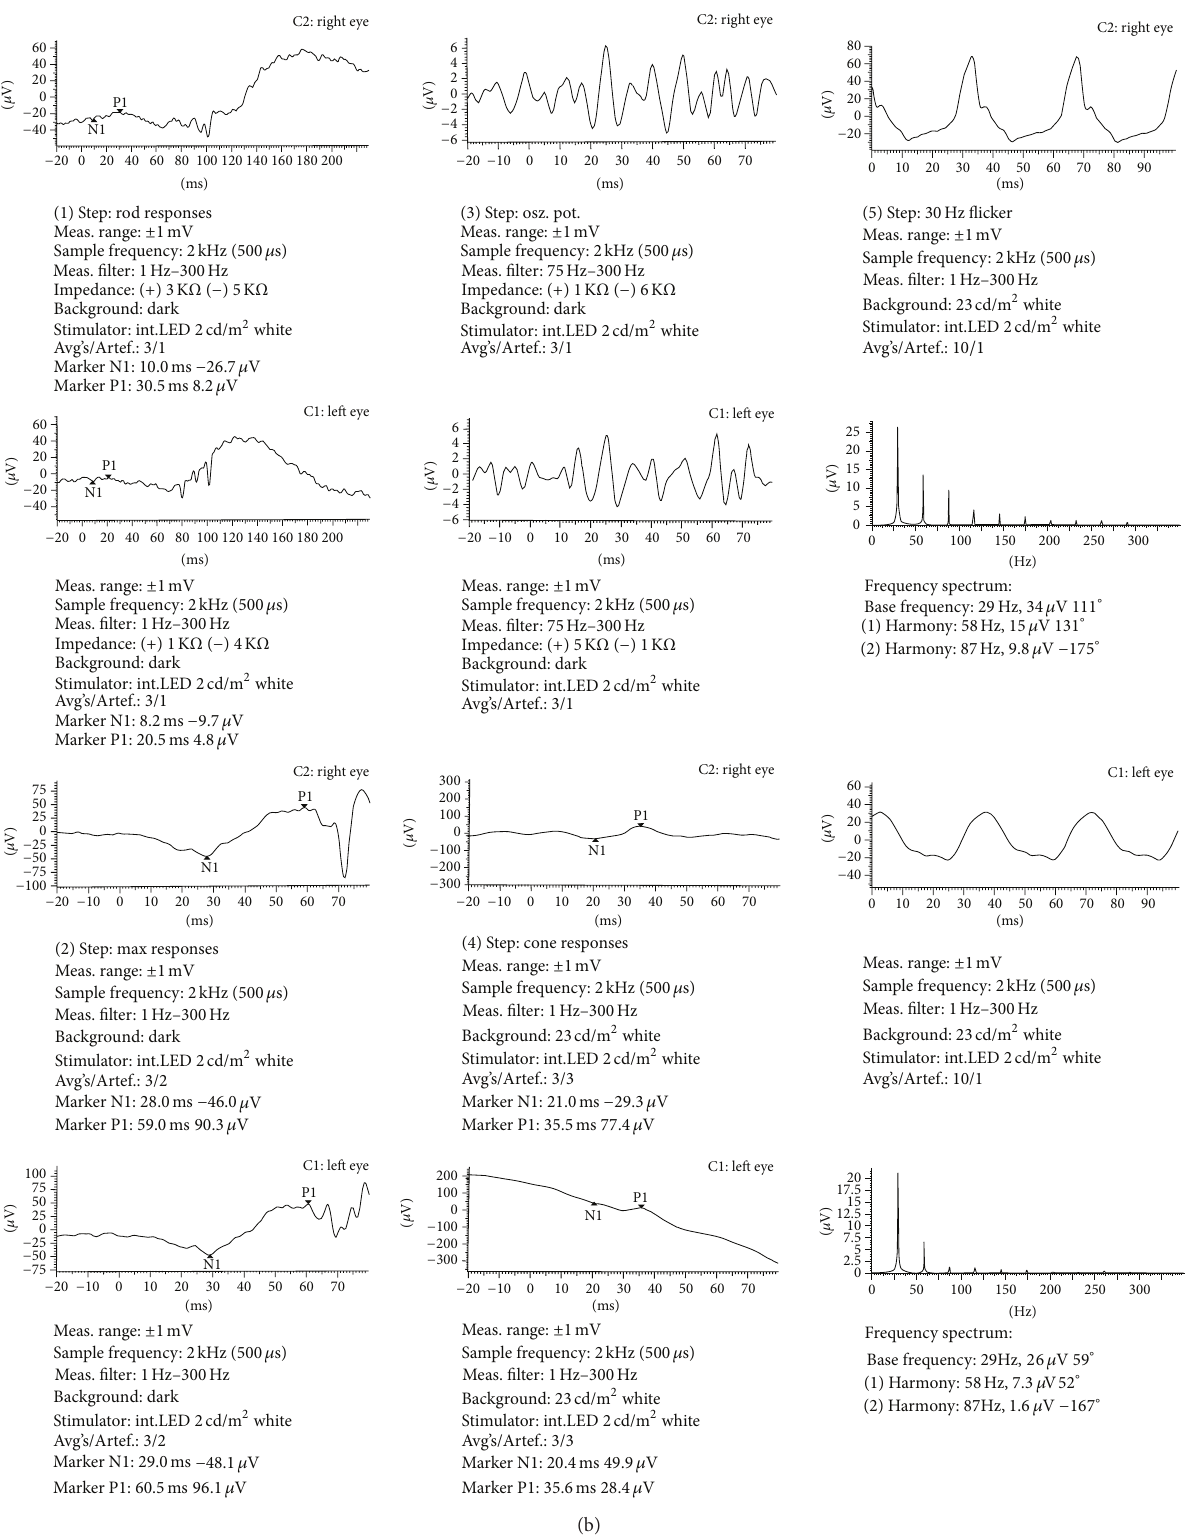
Figure 2: (a) Flash ERG studies of both eyes of a normal control. (b) Flash ERG findings of both eyes of the patient demonstrating the subnormal responses of dark adapted rods, maximum responses, photopic cone responses, and 30 Hz flicker stimulation